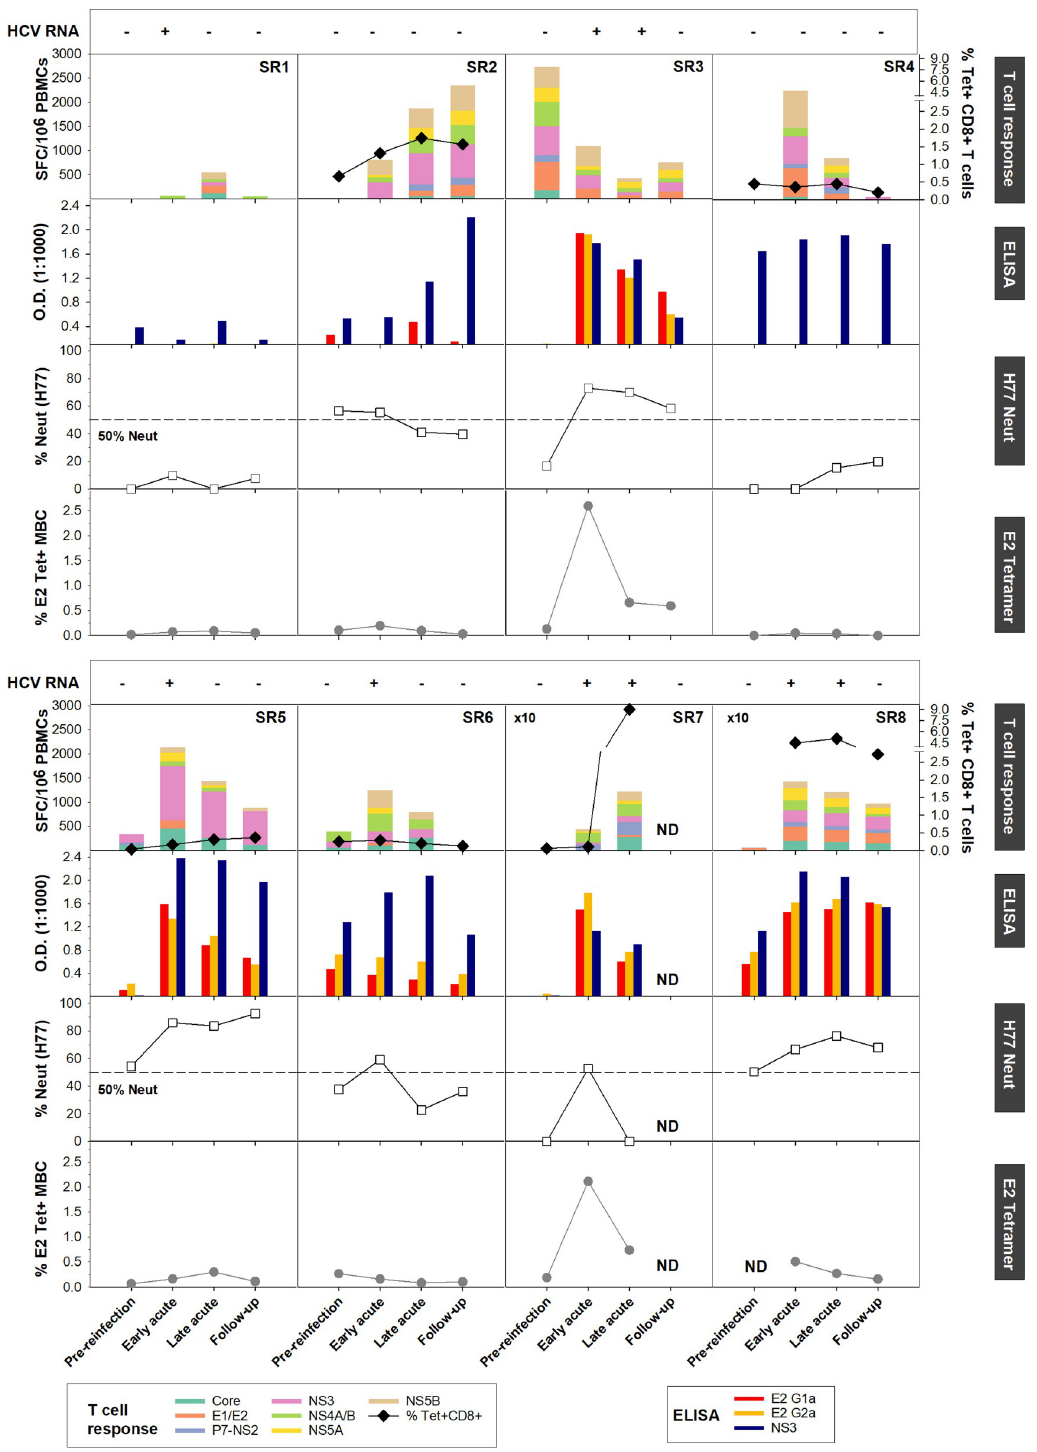
Fig 4. Concerted increase of HCV-specific T and B cell responses during acute reinfection. Results are presented per subjects with from top to bottom: (HCV RNA) Viremia status presented as viremia positive (+) and negative (-). (Longitudinal IFN- γ ELISpot responses and MHC class I tetramer+ CD8+ T cells) . PBMCs from the indicated time points were tested in an IFN- γ ELISpot assay against overlapping peptide pools representing the HCV H77 (SR2, SR3, SR5, SR6, SR7 and SR8) or J4 polyprotein (SR1 and SR4). The frequencies of IFN- γ spot forming cell (SFC) per million PBMCs from all subjects are presented in each top